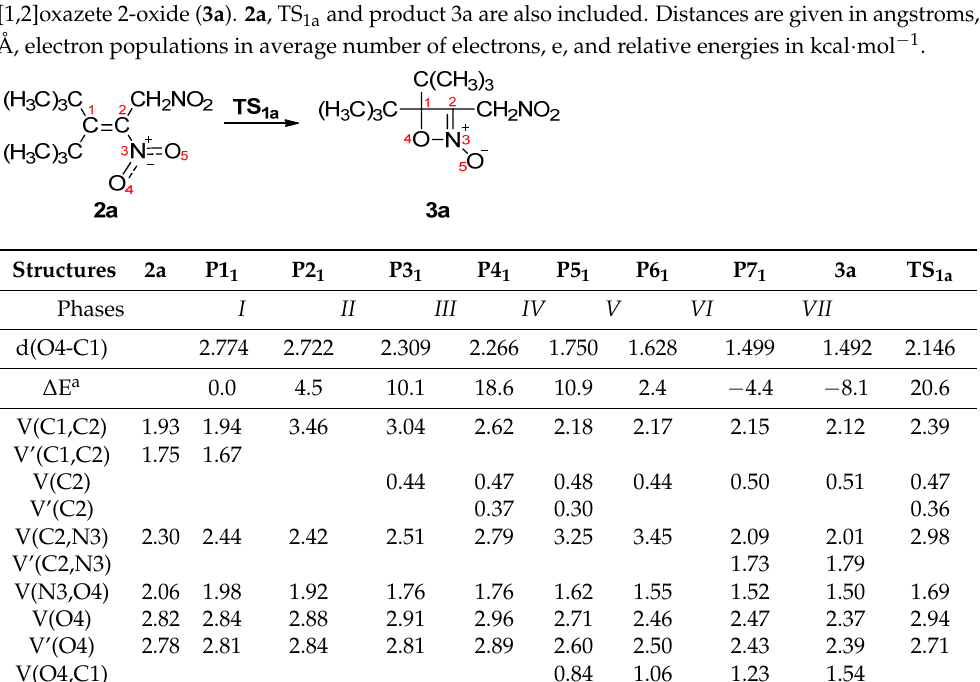
Figure 4. Attractor positions of the most important ELF valence basins of the IRC structures P1 1 – 3a together with simplified representation of the molecular mechanism by Lewis-like structures arising from the topological analysis of the ELF along the reaction path for the formation of 4,4-di-tert-butyl-3-nitromethyl-4H-[1,2]oxazete 2-oxide ( 3a ). Figure shows the most important ELF valence basin populations to illustrate which populations disappear and which form in the individual phase. The electron populations, in average number of electrons, is given in e. Table 2. ELF valence basin populations, distances of the forming bonds, MPWB1K/6-311G(d,p) relative a electronic energies ( ∆ E) of the IRC structures, P1 – 3a , defining the seven different phases characterizing the molecular mechanism of the formation of the 4,4-di-tert-butyl-3-nitromethyl-4H-